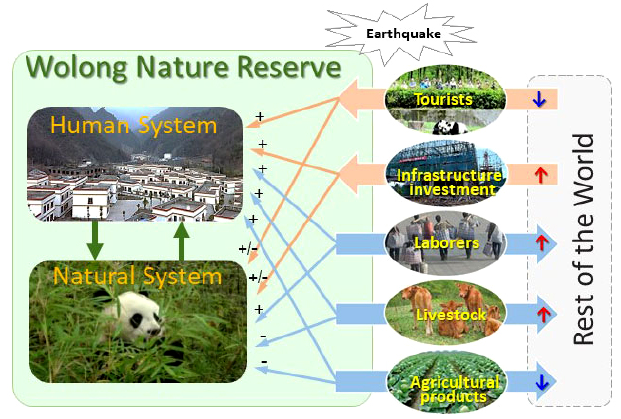
Fig. 5 . Changes in telecouplings between Wolong and the outside world due to the 2008 Wenchuan earthquake, and potential effects on the local human and natural systems in Wolong. “+” and “-” indicate positive and negative effects on human or natural systems, respectively. Detailed variation of flows is shown in Figure 3. Upward facing arrows indicate increasing flows, and downward facing arrows indicate decreasing